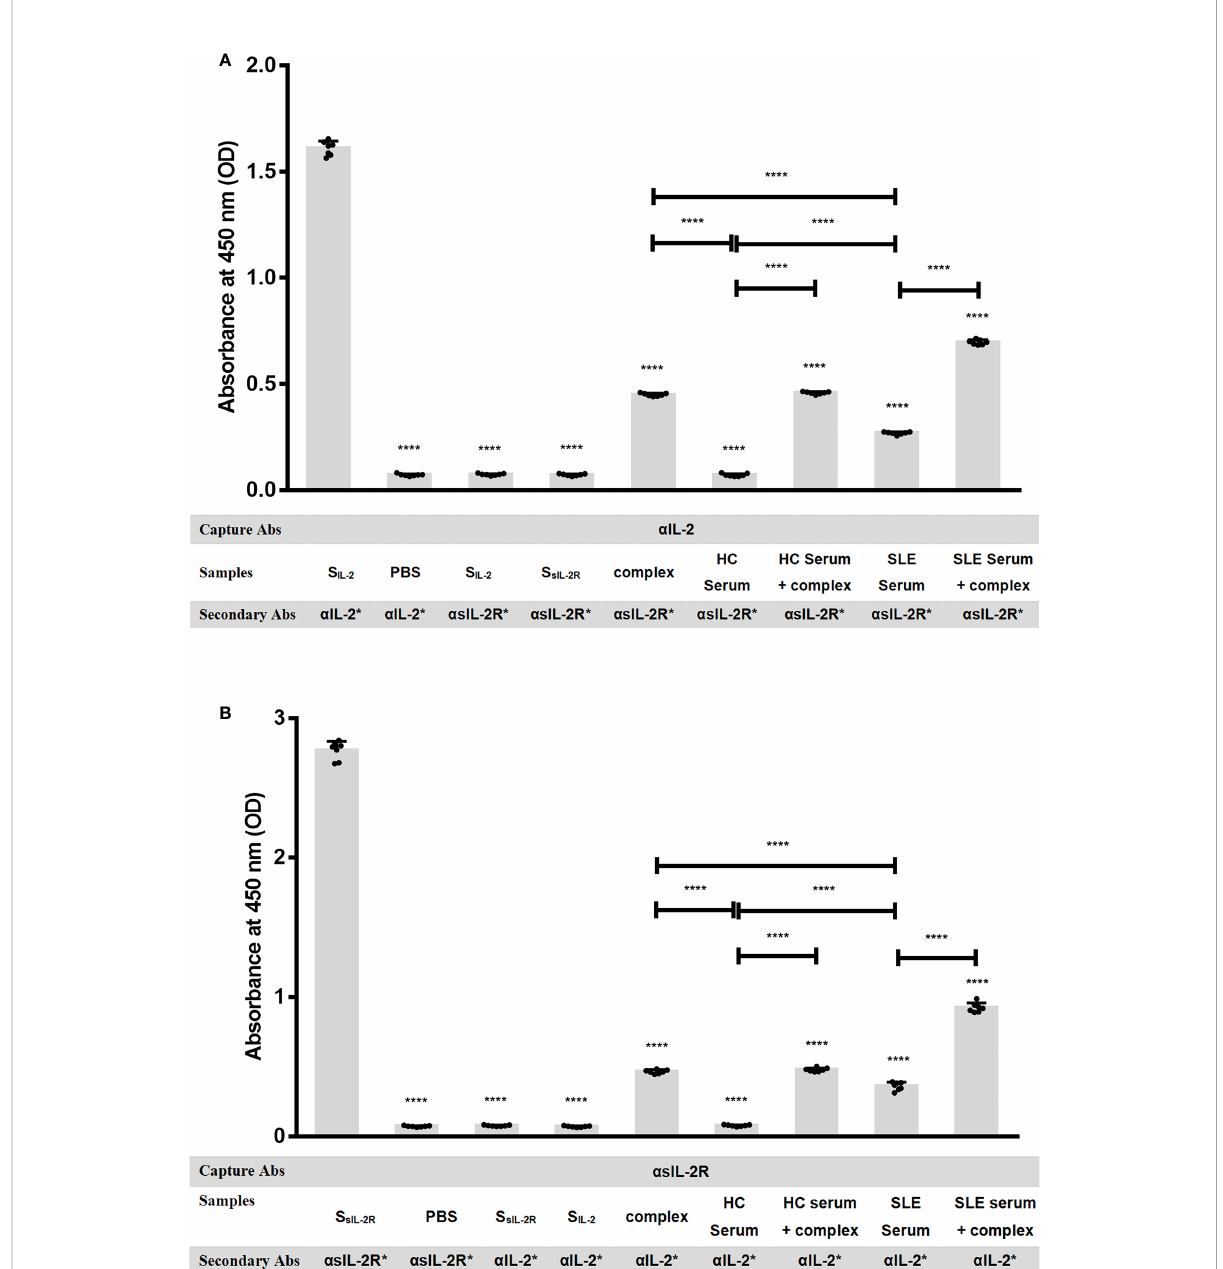
FIGURE 3 sIL-2R a /IL-2 complex detection by mixed solid-phase sandwich ELISA. (A) Microplates pre-coated with anti-IL-2 antibody were used to detect heterodimeric sIL-2R a /IL-2 complex in PBS, IL-2 standard, sIL-2R a standard, serum of healthy controls, serum of SLE patients or heterodimeric complexes formed by pre-incubation of recombinant IL-2 ( fi nal concentration of 6 pg/ml) with sIL-2R a ( fi nal concentration of 2500 pg/ml), in the condition of matching different labeled secondary antibodies (n=7). (B) Microplates pre-coated with anti-sIL-2R a antibody were used to detect heterodimeric sIL-2R a /IL-2 complex in PBS, sIL-2R a standard, IL-2 standard, serum of healthy controls, serum of SLE patients or heterodimeric complexes formed by pre-incubation of recombinant IL-2 ( fi nal concentration of 6 pg/ml) with sIL-2R a ( fi nal concentration of 2500 pg/ml), in the condition of matching different labeled secondary antibodies (n=7). Data were expressed as mean ± standard deviation (SD) of at least three independent experiments. Statistical signi fi cance was determined by one-way analysis of variance (ANOVA) followed by post hoc test. SLE, systemic lupus erythematosus; HCs, healthy controls; a IL-2: anti-IL-2 antibody; a sIL-2R a : anti-sIL-2R a antibody; S IL-2; S sIL-2R a , standard of sIL-2R a ; complex, heterodimeric complexes formed by pre-incubation of recombinant IL-2 with sIL-2R a . *: labeled. “ NS ” means no signi fi cance; *p < 0.05; ****p <